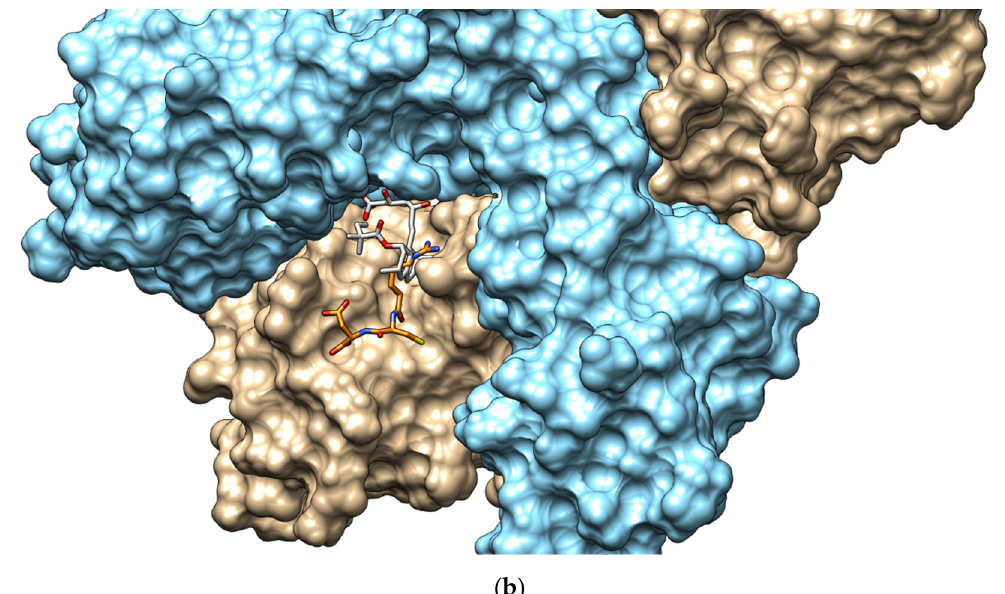
Figure A2. Docking analysis of simvastatin and the ( a ) SNV peptide and the ( b ) RCD peptide with the HMG-CoA reductase (PDB 1HW9). Both the simvastatin and the peptides are shown in sticks, whereas the surface of the HMG-CoA reductase was shown. The simvastatin (C, light grey; N, blue; O, red; S, yellow), SNV (C, pink; N, blue; O, red; S, yellow), and RCD (C, orange; N, blue; O, red; S, yellow) are colored by elements.